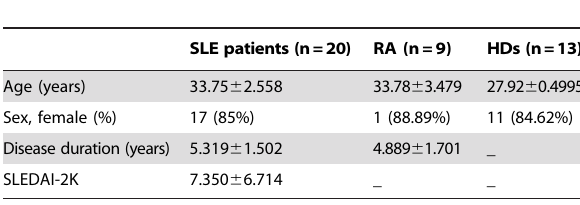
Table 1. Demographics of SLE and RA patients and healthy